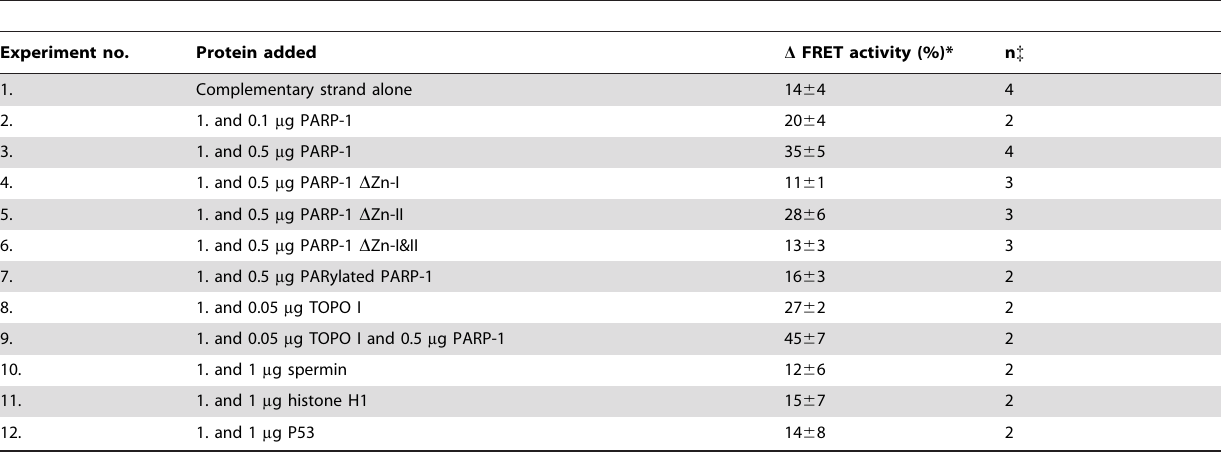
*decrease in FRET activity during one minute (% of decrease in the maximal height of the FRET peak measured at 0 time). { number of experiments.